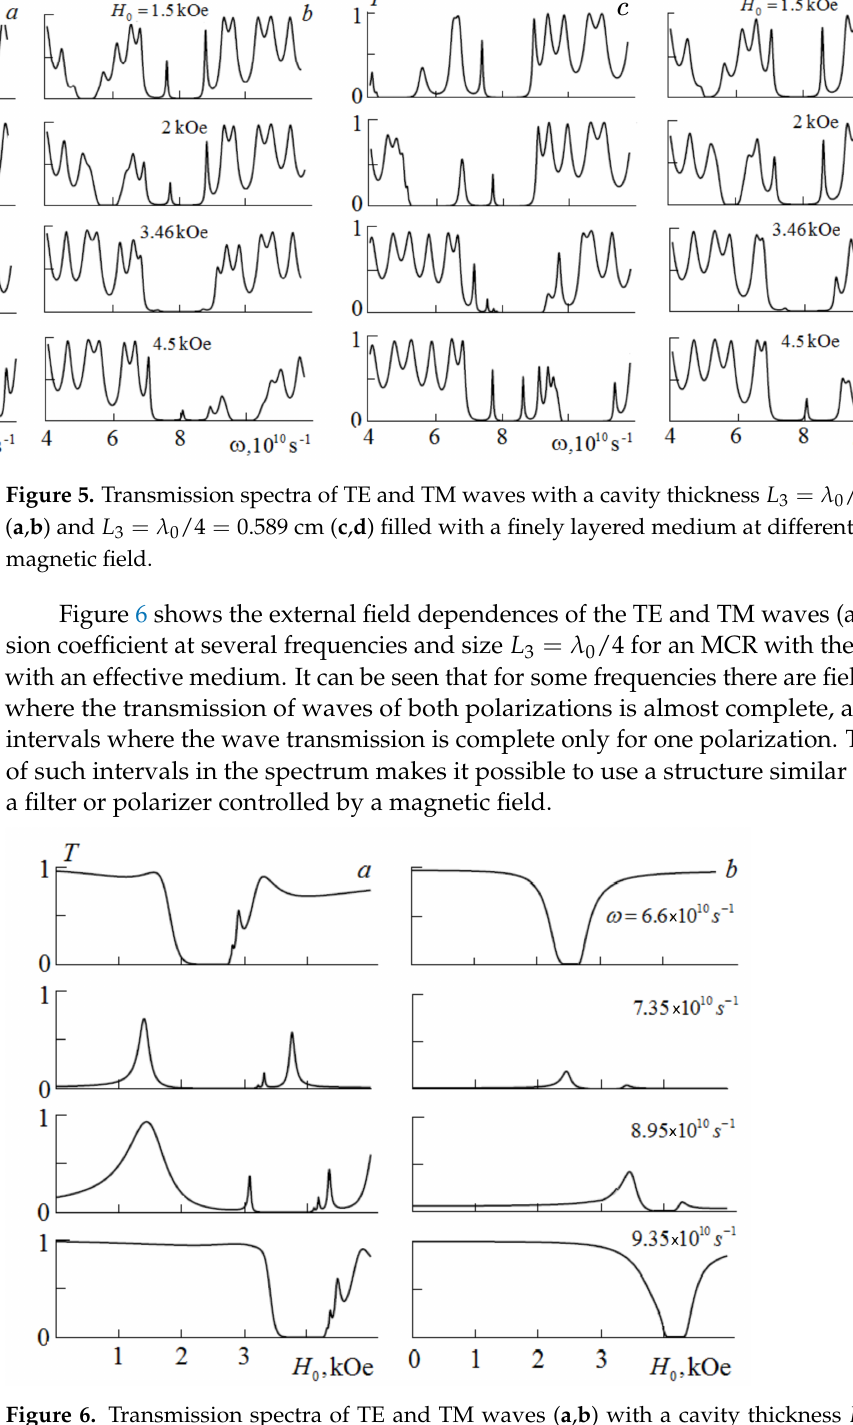
Figure 6. Transmission spectra of TE and TM waves ( a , b ) with a cavity thickness L 3 = λ 0 /4 = 0.589 cm filled with a finely layered medium at different